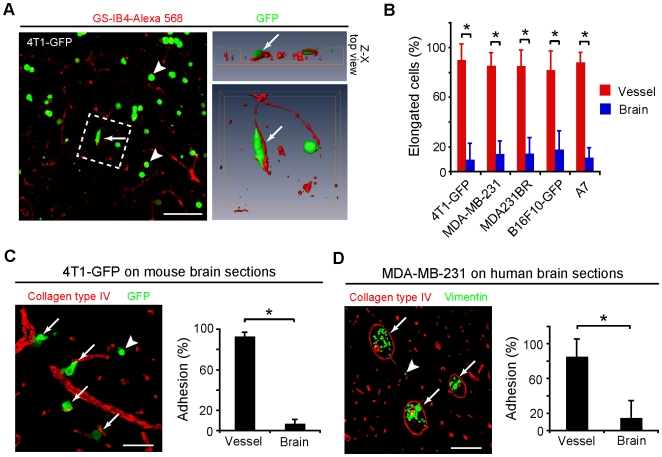
Tumor cell interactions with CNS vessels.(A) 4T1-GFP cells were plated onto live adult murine brain slices and fixed after 2 h of co-culture. 3-D reconstructions of hatched area (right panels) verify that the elongated tumor cell is spreading upon a vessel (arrows). Scale bar, 120 µm. (B) Quantitation of vascular association on live brain slices with several mouse and human tumour lines demonstrates the vast majority of elongated cells (82–90%) are attached to vessels (*P<0.05, Mann-Whitney U-test, n = 294–546 cells per line, 2 independent experiments in duplicate). (C) 4T1-GFP cells were plated onto slide-mounted tissue sections of murine brain for 2 h and non-adherent cells were rinsed off. Tumor cells preferentially attached to vessels (arrows) rather than the neural elements (arrowhead). Graph, the location of the adherent cells was assessed (*P<0.01, Mann-Whitney U-test, 2 independent experiments in triplicate). Scale bar, 60 µm. (D) Human MDA-MB-231 cells (arrows) were plated on slide-mounted human brain sections. They similarly attached to vessels preferentially (arrows) over the neural parenchyma (arrowhead). (*P<0.01, Mann-Whitney U-test, n = 3 patient samples, 2 independent experiments in duplicate). Scale bar, 240 µm. All error bars represent s.d.